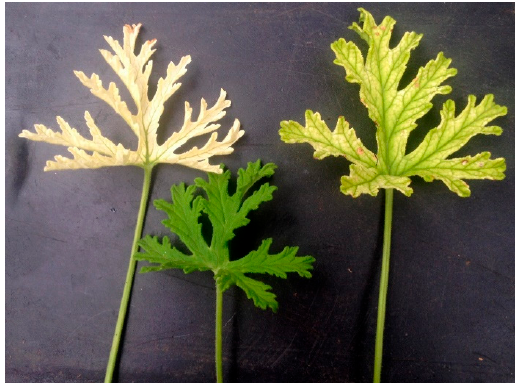
Figure 1. A non-symptomatic leaf (center) and leaf discoloration in symptomatic plants